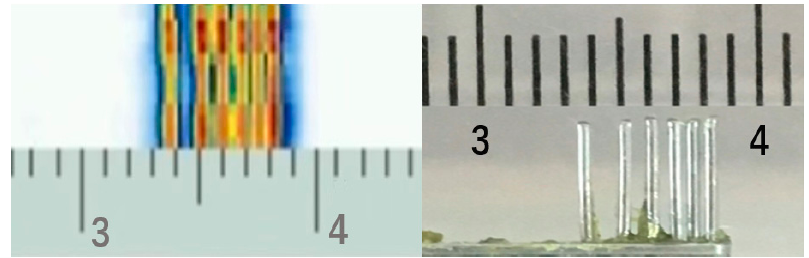
Figure 14. C-scan pulse-echo imaging of a homemade mold.